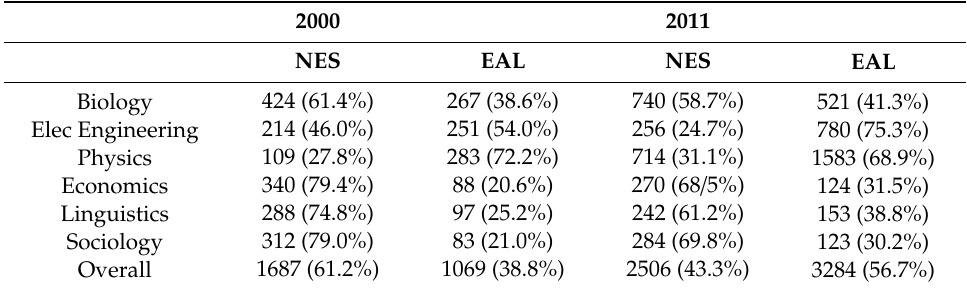
Table 1. First author for articles published in top five journals by Impact Factor 1 .